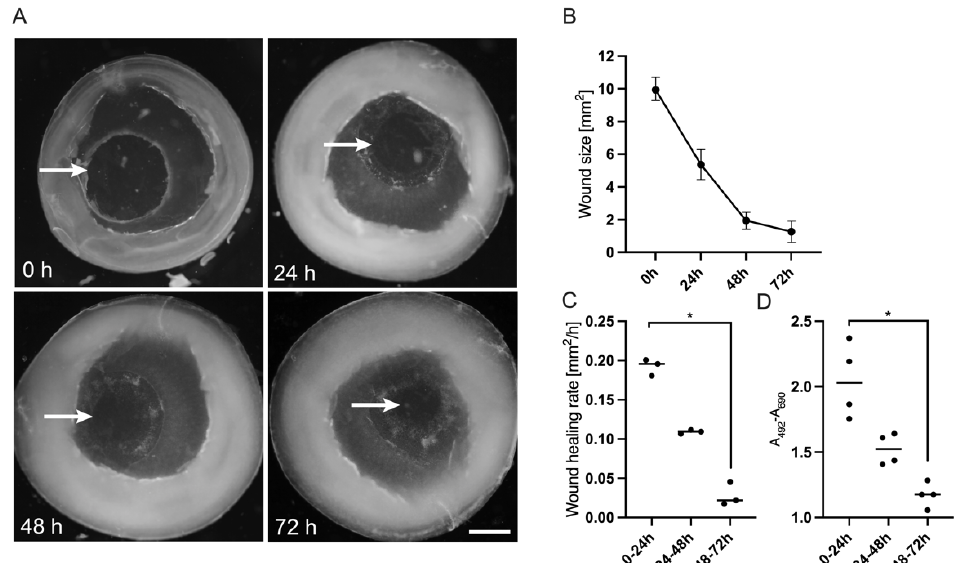
Figure 2. Optical documentation and analysis of wound healing in corneal organ culture model for 72 h. The wound healing process of corneas during ex vivo culture was monitored with a stereomicroscope. The specimens were cultivated in DMEM (see Table 2) for up to 72 h. ( A ) The epithelial wound margin after using a 4 mm punch could be identified at the start of the experiment (arrow, 0 h). During wound healing the margins of the newly formed epithelium could be followed visually (arrows at 24, 48 and 72 h). ( B ) The wound area was calculated at 0 h, 24 h, 48 h and 72 h and the median (range) was calculated from three specimens. ( C ) The wound healing rate was calculated for every 24 h from the start as mm 2 per hour. D: Vitality of the corneal tissue was evaluated by measuring release of lactate dehydrogenase (LDH). The absorbance of organ culture supernatant was evaluated after 24 h, 48 h and 72 h. Scale bar measures 2 mm. Sample size n = 3 for ( B , C ), n = 4 for ( D ). Statistically significant differences are indicated as *: p < 0.05.